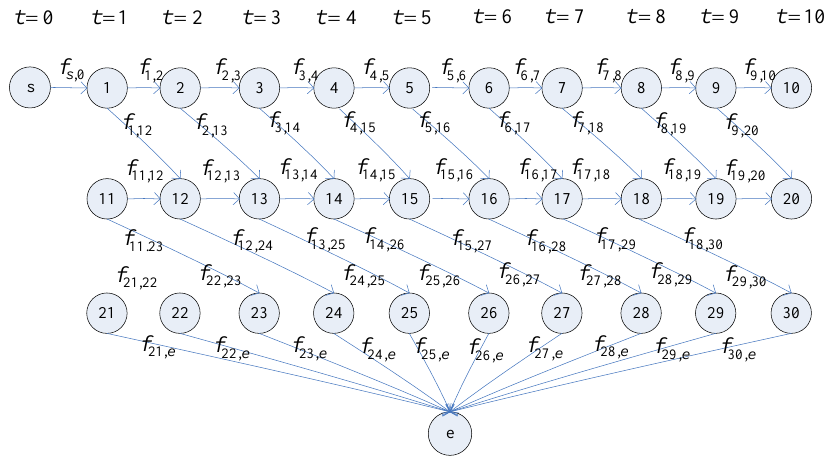
Figure 4. An example of STN j ( V j , A j ) for GJ 1 ( j = 1) in Figure 1a. Let A jrt denote the set of arcs involved in the use of type- r resource in period t in STN j ( V j , A j ) . The capacity constraints (1), the flow balance Equation (2), supply con- straints (3) and demand constraints (4) must hold. Based on the spatial-temporal network STN j ( V j , A j ) , the following problem is formulated to check the feasibility to meet product demands, Q j , by the deadline θ